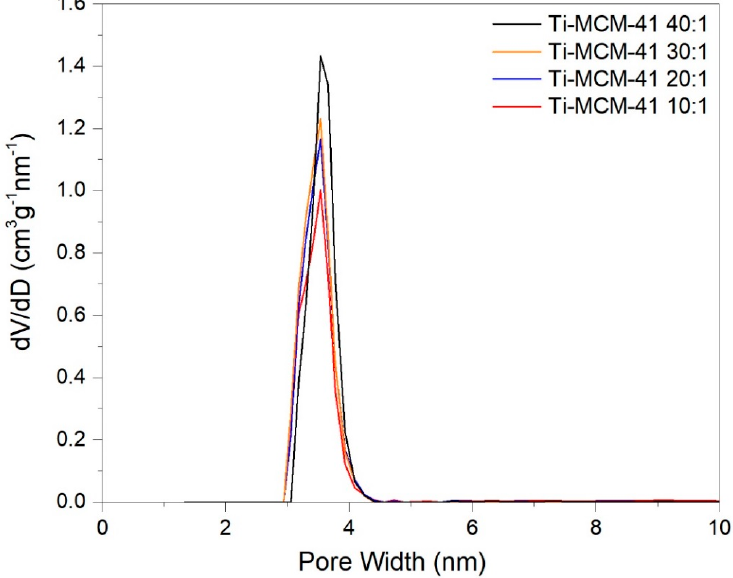
Figure 8. Pore-size distribution for Ti-MCM-41 catalysts with different molar ratios of Si:Ti in the crystallization gel.